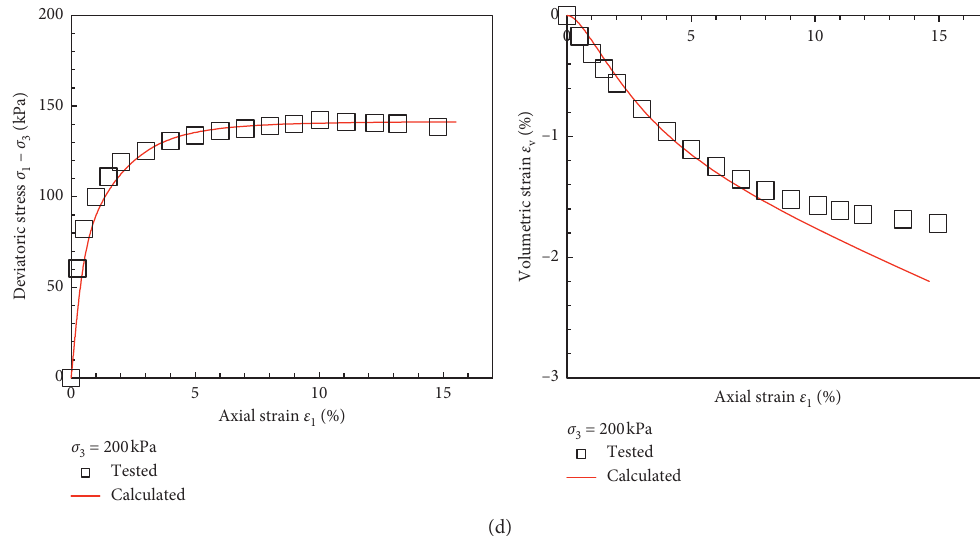
Figure 13: Comparisons between experimental data and the calculated results for the stress-strain curves and volumetric strain-axial strain curves. (a) Conventional triaxial compression path CTC (CD). (b) Conventional triaxial compression path CTC (CU). (c) Triaxial compression path TC. (d) Reduced triaxial compression path